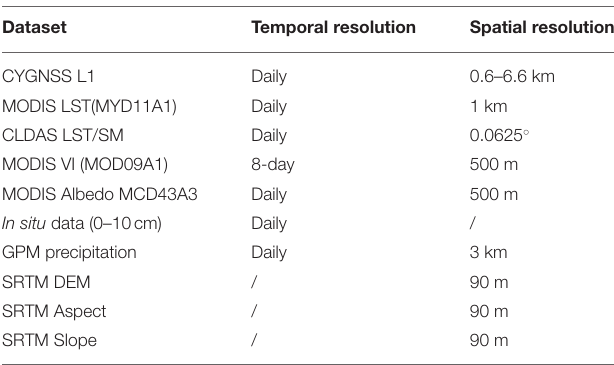
TABLE 2 | Summary of the datasets used in this